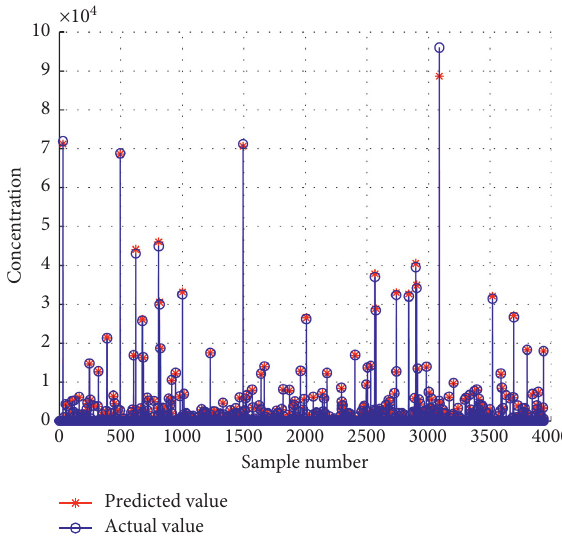
Figure 16: The fitting effect diagram of Jinan training set data.